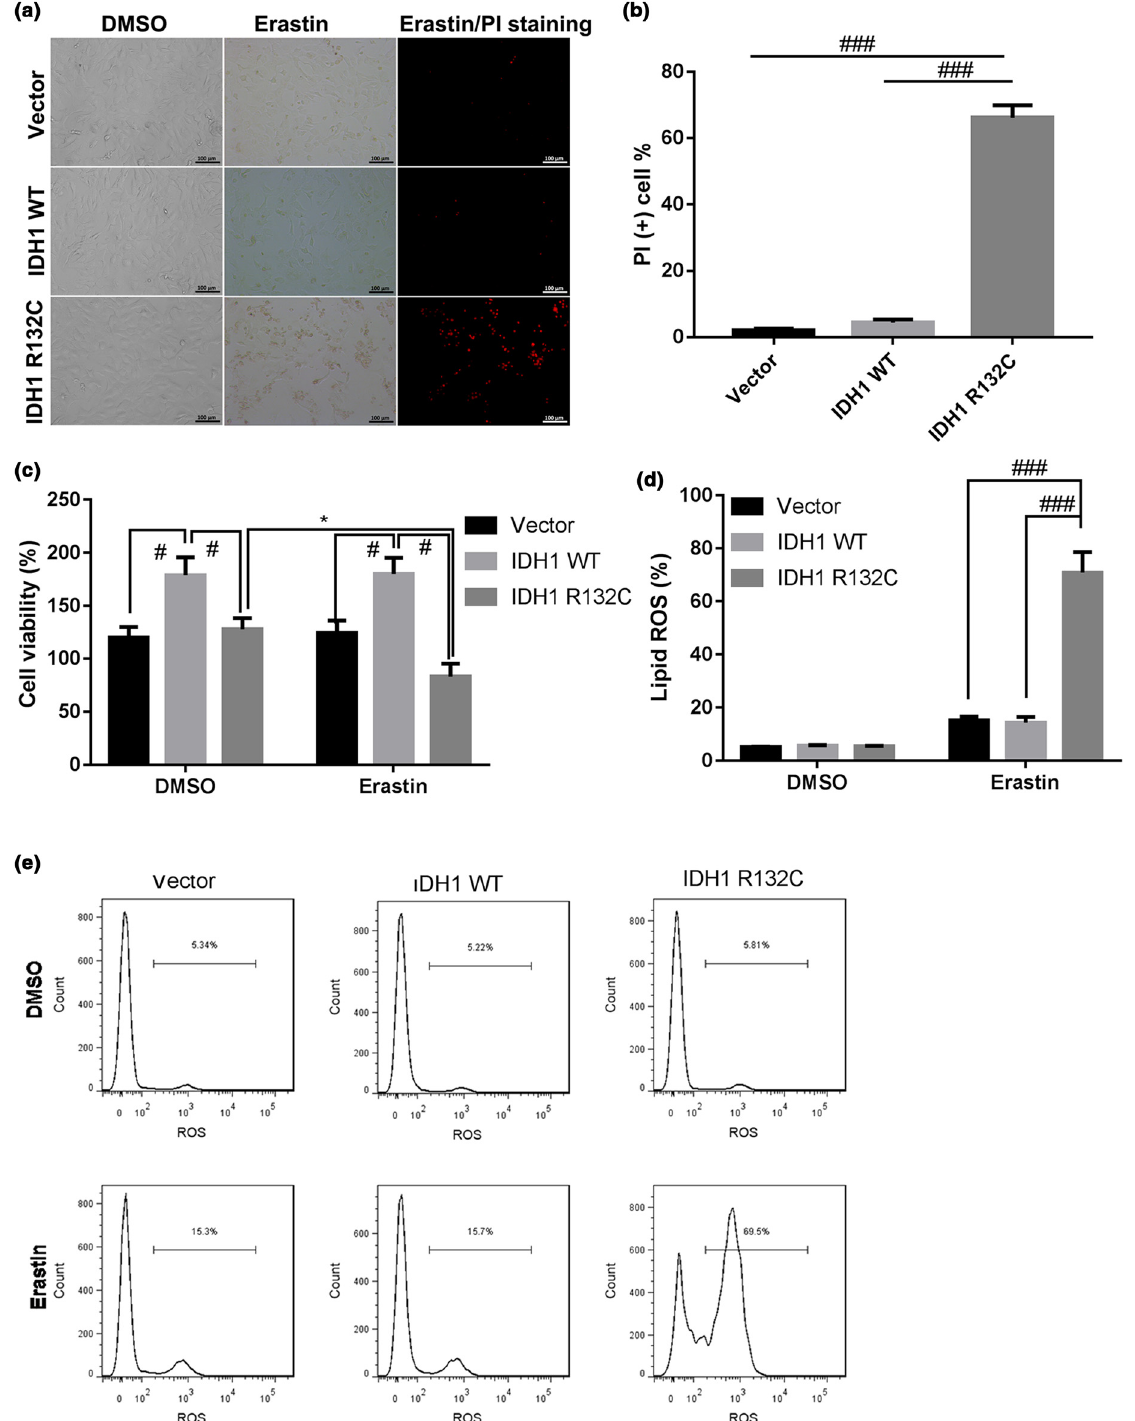
Figure 1: IDH1 mutation promotes erastin - induced ferroptosis in cholangiocarcinoma RBE cell line. The IDH1 KO RBE cell line was constructed using CRISPR - Cas9, and then the IDH1 KO cell line was, respectively, transfected with Vector, IDHI WT, or IDHI R132C mutation plasmid to construct the IDH1 WT or mutation cell lines, followed by erastin ( 5 μ M ) treatment for 12 h, and ( a ) cells were microscopically photographed. ( b ) The number of PI - positive cells was statistically quanti fi ed. ( c ) The trypan blue staining assay was used to determine the cell viability. ( d and e ) The lipid ROS levels were determined by using fl ow cytometer. * p < 0.05 vs DMSO treatment group, # p < 0.05, ### p < 0.001 vs IDH1 WT or IDH1 R132C